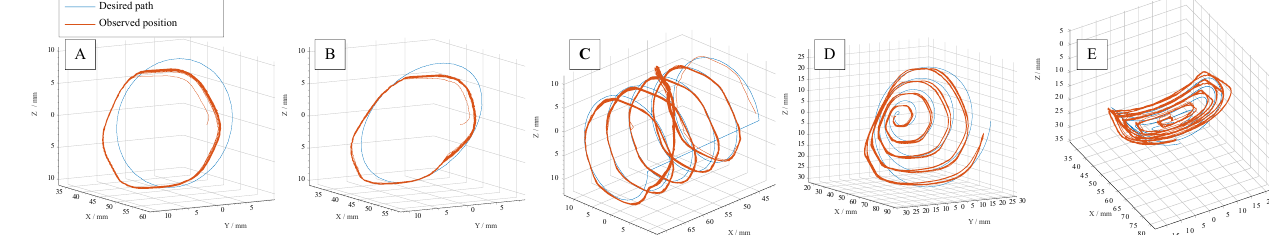
Figure 8. Results of path following tests for the three-DOF setup. ( A ) Circle 10 mm diameter. ( B ) Circle at 45° pitch. ( C ) Helix 20 mm diameter. ( D ) Conic spiral 30 mm base. ( E ) Spiral projected onto 20 mm diameter cylinder.